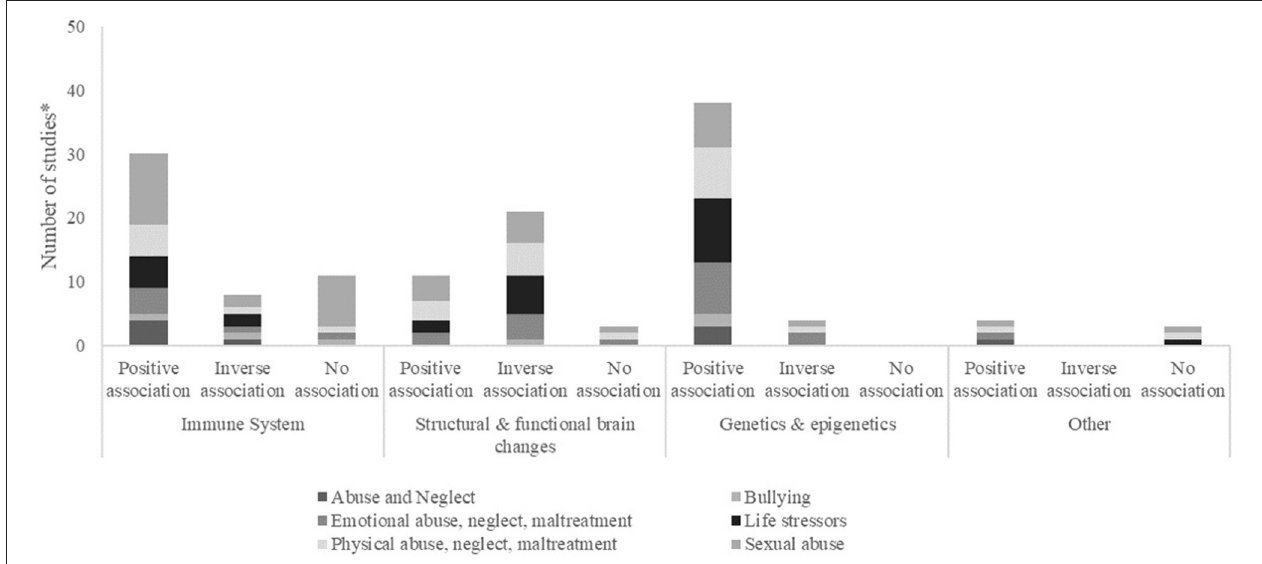
FIGURE 3 | Frequency (number of studies*) categorized by presence of association (positive, negative) or absence of association (no association) found between exposure to ACEs and biomarker, by biological mechanism and type of ACE. *Some papers evaluated more than one biomarker, within or not the same biological